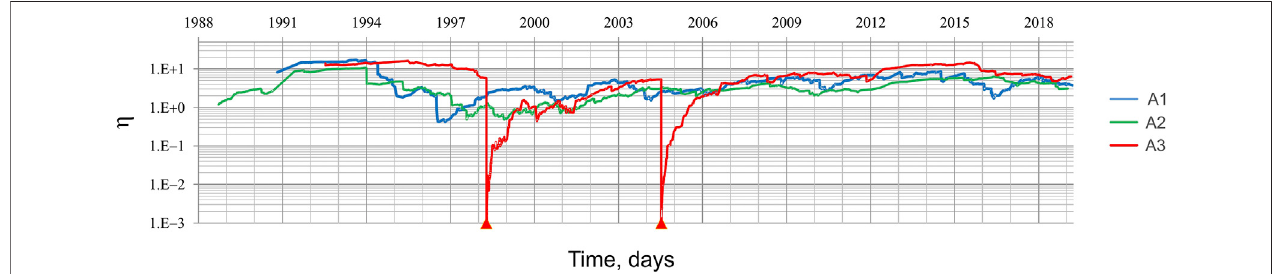
FIGURE 7 | USLE control parameter η (1988 – 2019) moving average per 50 events in three FVG sub-regions vs. earthquake origin time (A1 – blue line, A2-green line, A3 – red line). Note: the origin times of the two principal earthquakes ( Table 2 ) are marked with red triangles on the origin time scale.